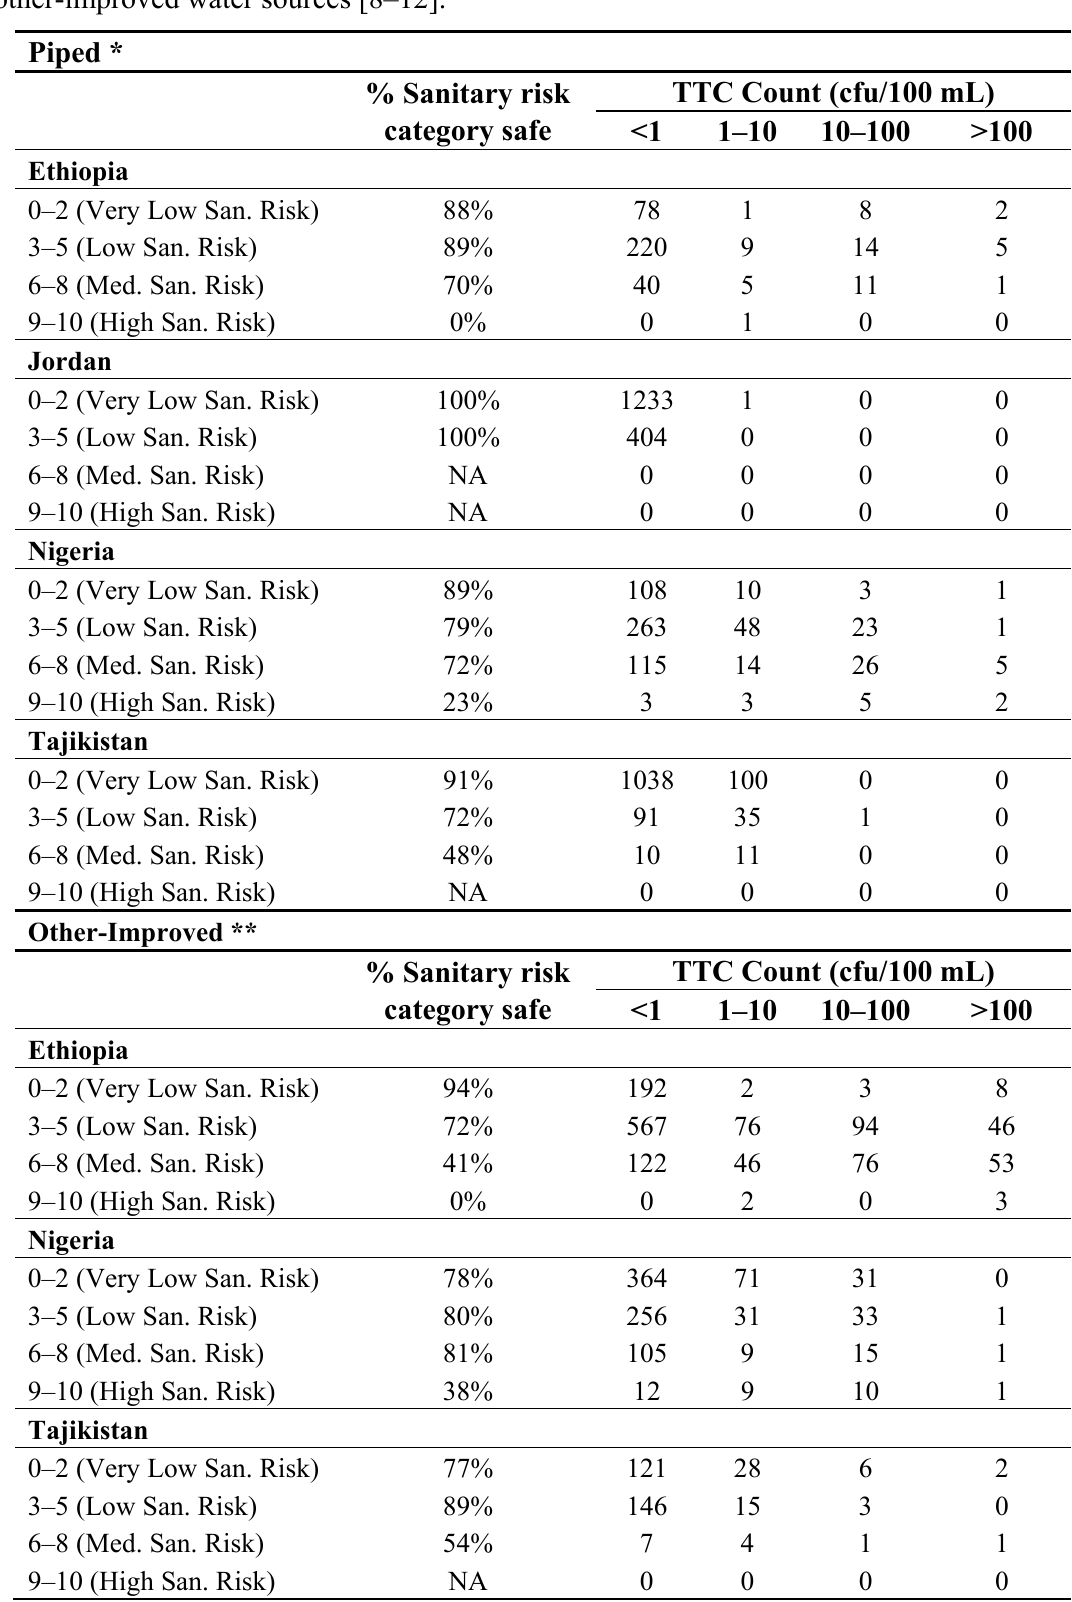
Table 2. Cross-tabulation of TTC contamination and sanitary risk for piped and other-improved water sources